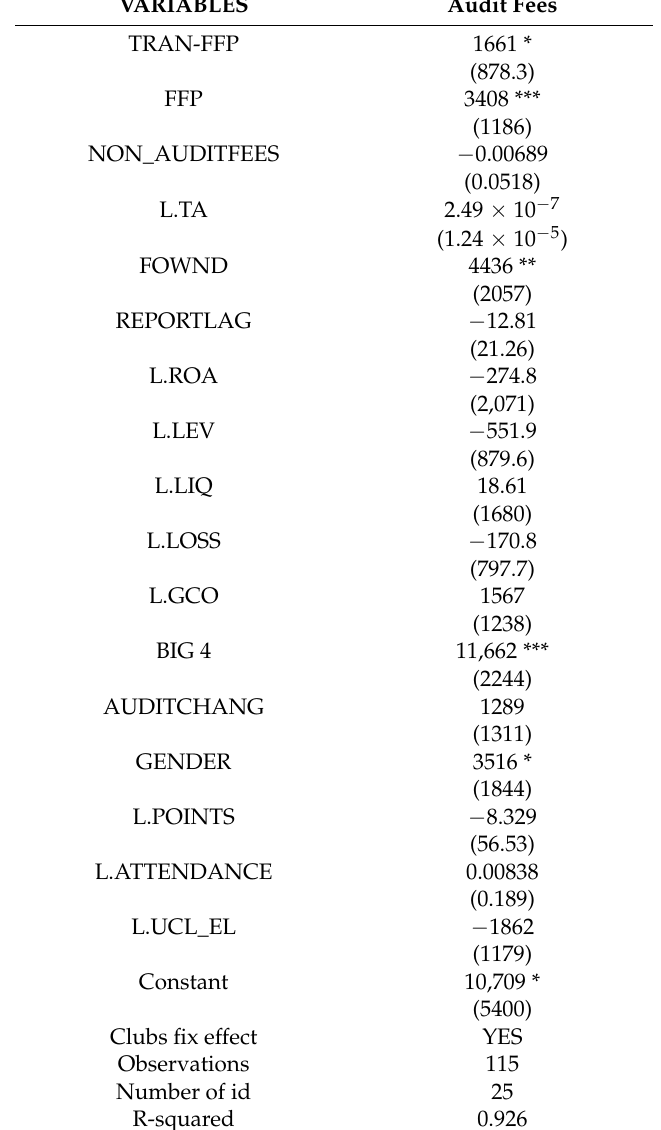
Table 7. Outputs of the regression (real